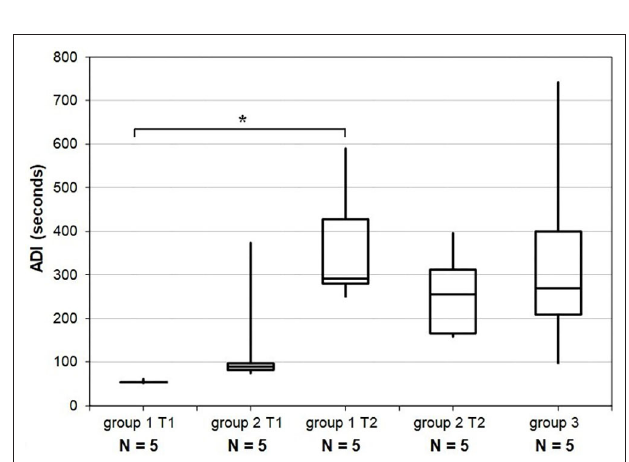
FIGURE 6 | Results for the average duration of intervals spent in quiet sleep. Distributions for each group and according to recording time T1 and T2. Horizontal lines grouping a pair of boxes denote statistically significant differences (* p < 0.05) in a Mann-Whitney u -test. ADI T1, average duration of intervals at recording time 1; ADI T2, average duration of intervals at recording time 2; GA, gestational age; PMA, post-menstrual age.